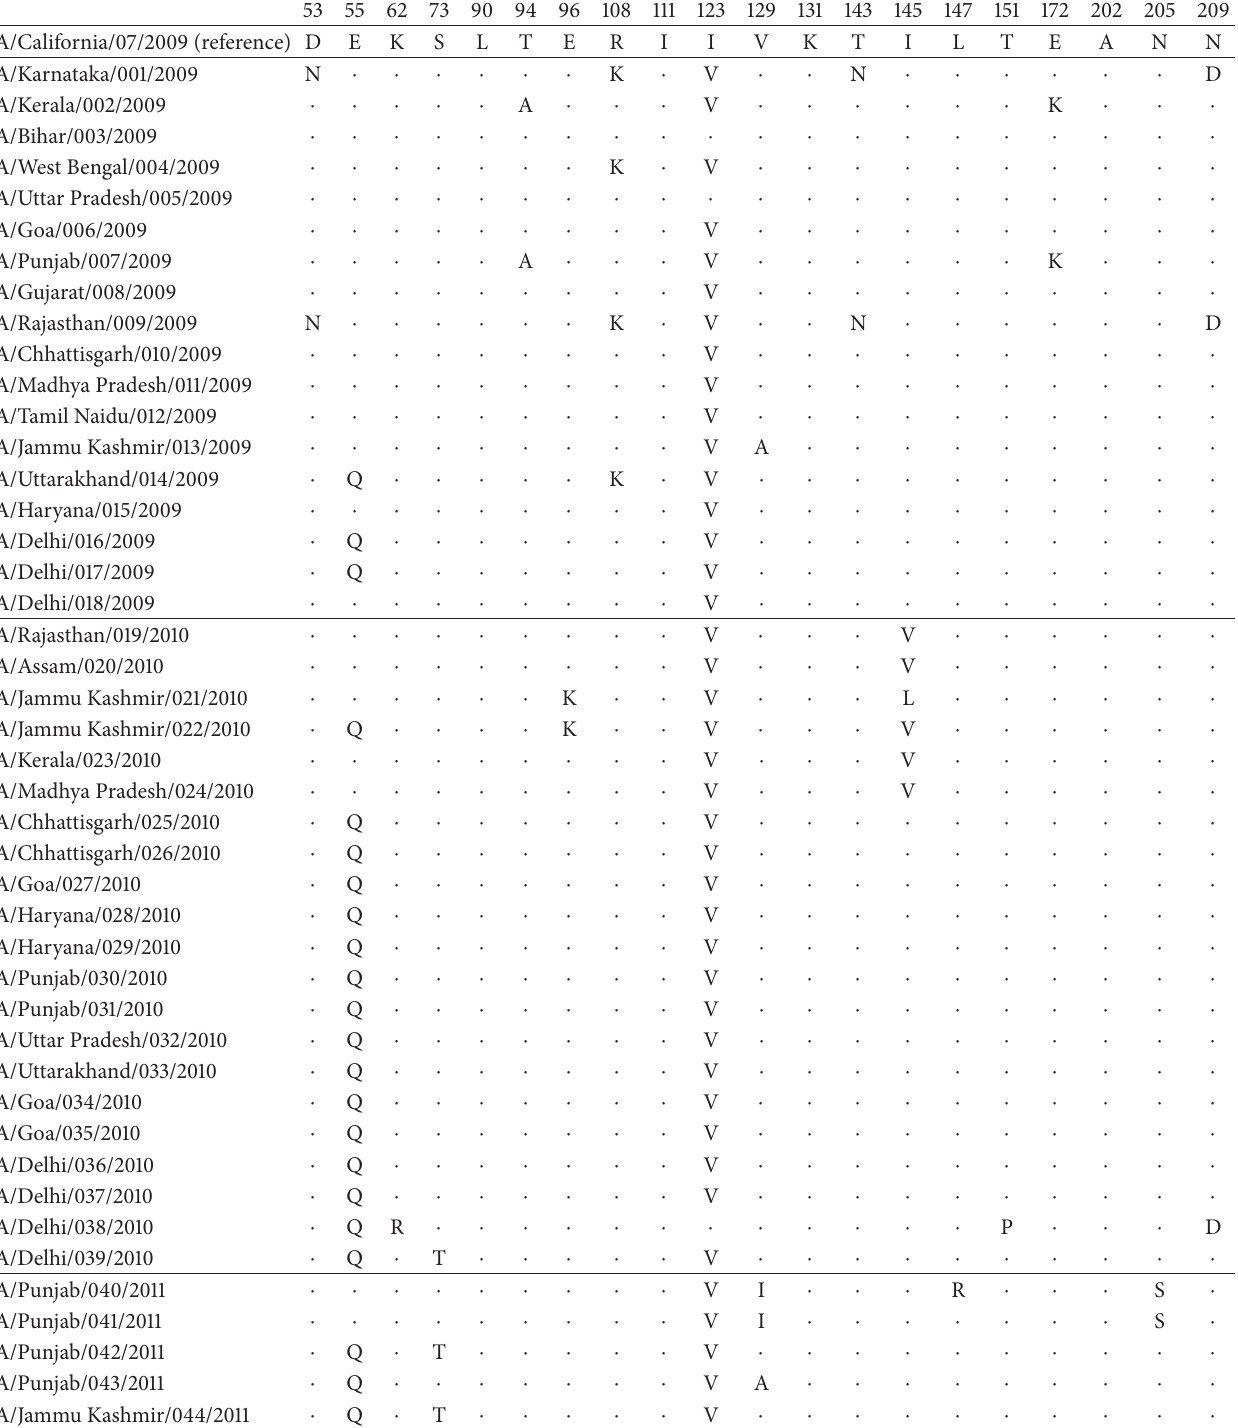
Table 3: NS1 protein positions with variable amino acids in study samples (2009–2013) with reference to A/California/07/2009 reference strain for pandemic H1N1 2009. Reference strain sequence is highlighted with bold font and study samples were arranged according to year of collection and separated with horizontal